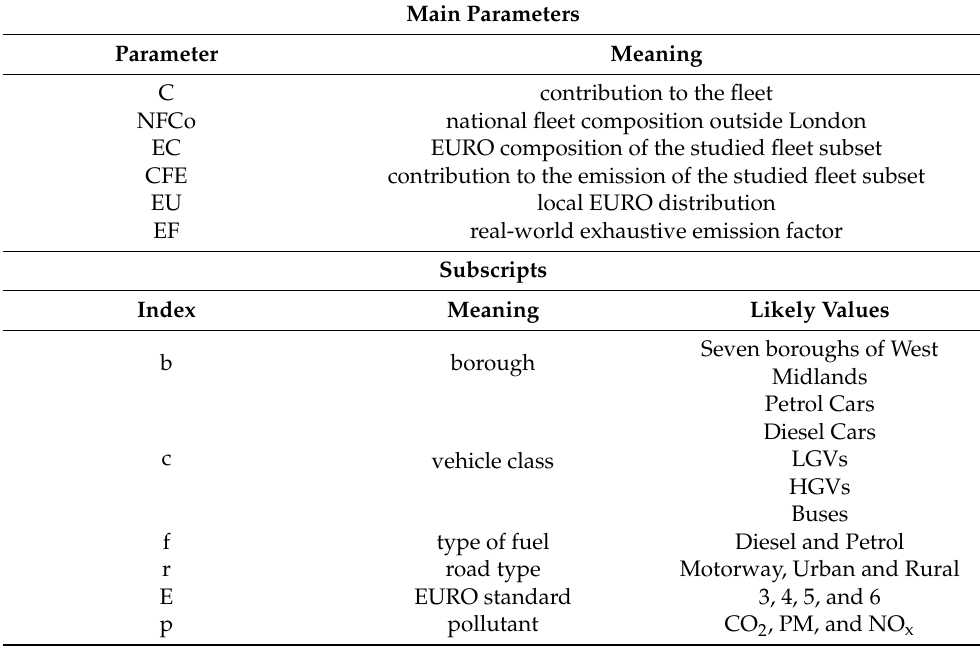
Table 4. The list of introduced parameters and